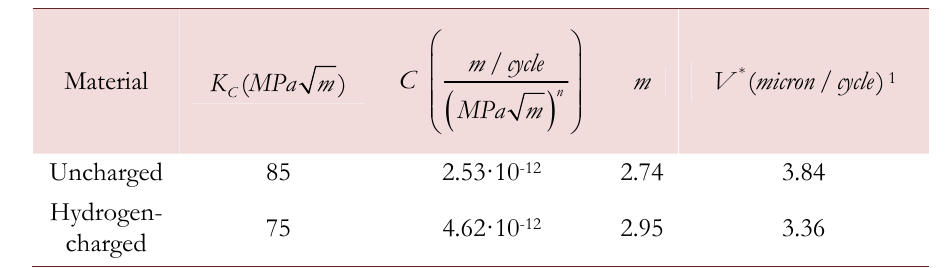
Table 3: The fracture toughness and the fatigue crack growth rate parameters